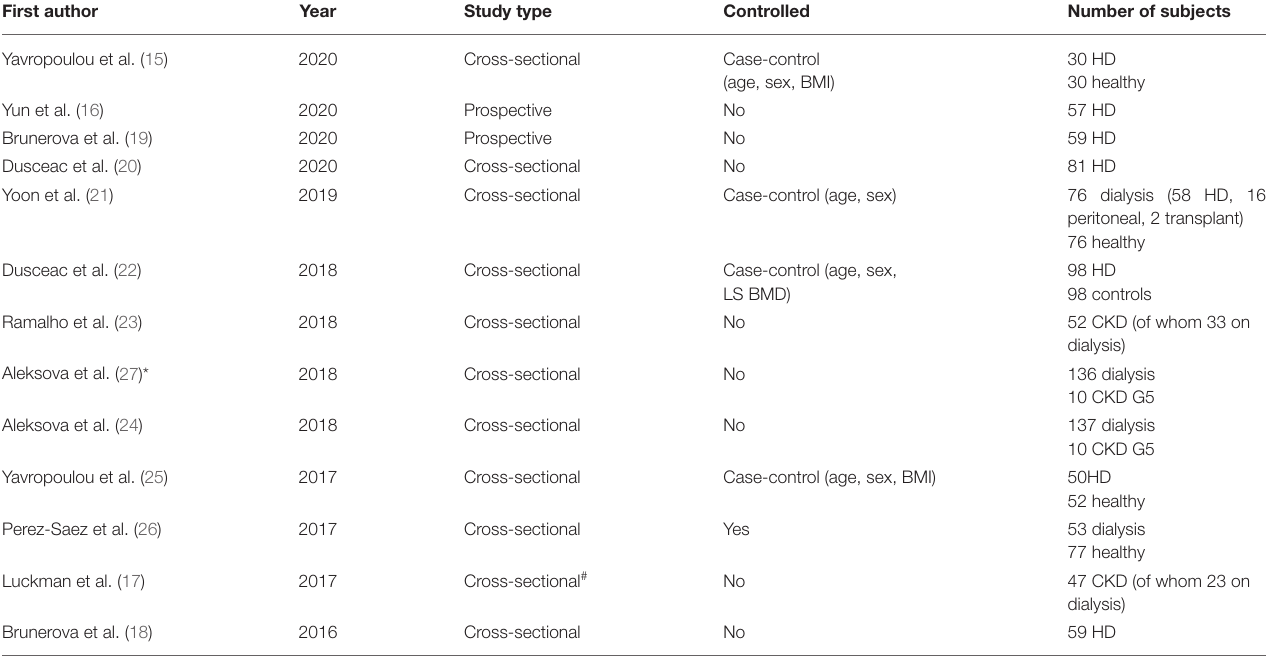
TABLE 1 | Characteristics of the included